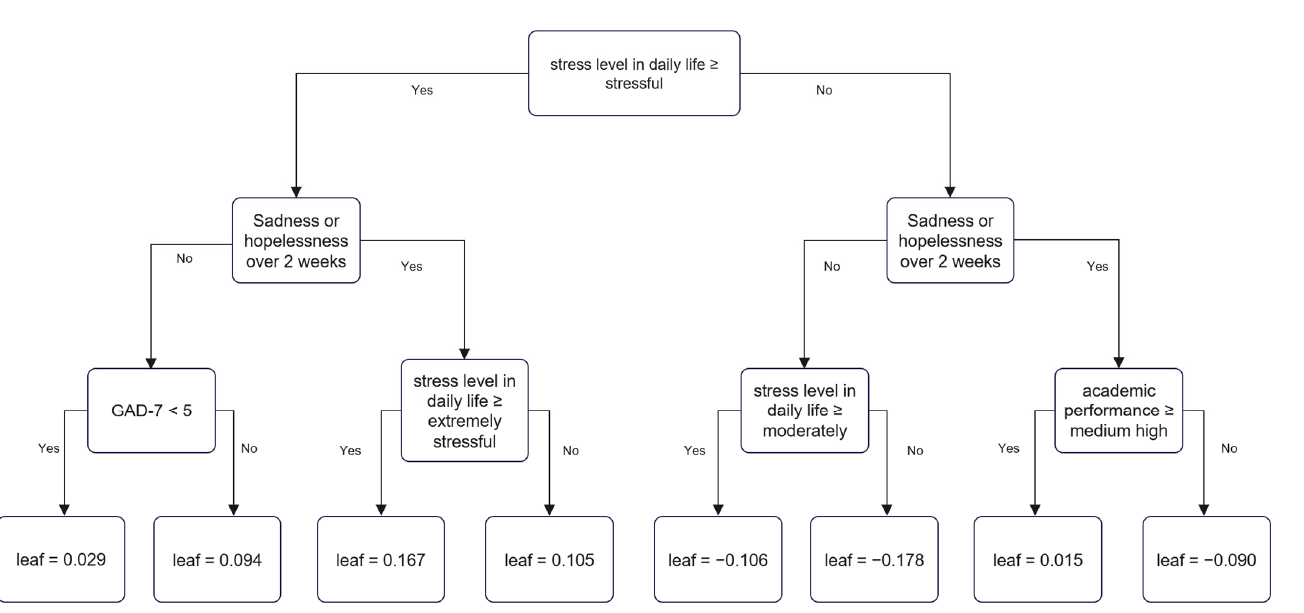
Figure 1. Decision tree of suicidal ideation in high socioeconomic status group by XGBoost.